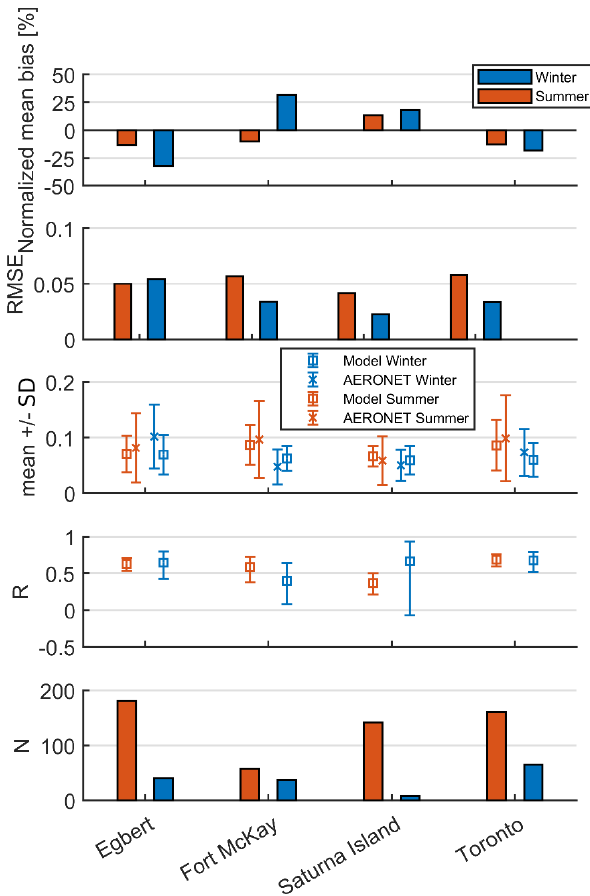
Figure 8. Statistical analysis of GEM-MACH AOD vs. AERONET AOD at 580nm in January and June 2018 at four Canadian AERONET sites: Egbert (44.23 ◦ N, − 79 . 78 ◦ W), Fort McKay (57.18 ◦ N, − 111 . 64 ◦ W), Saturna Island (48.78 ◦ N, − 123 . 13 ◦ W) and Toronto (43.79 ◦ N, − 79 . 47 ◦